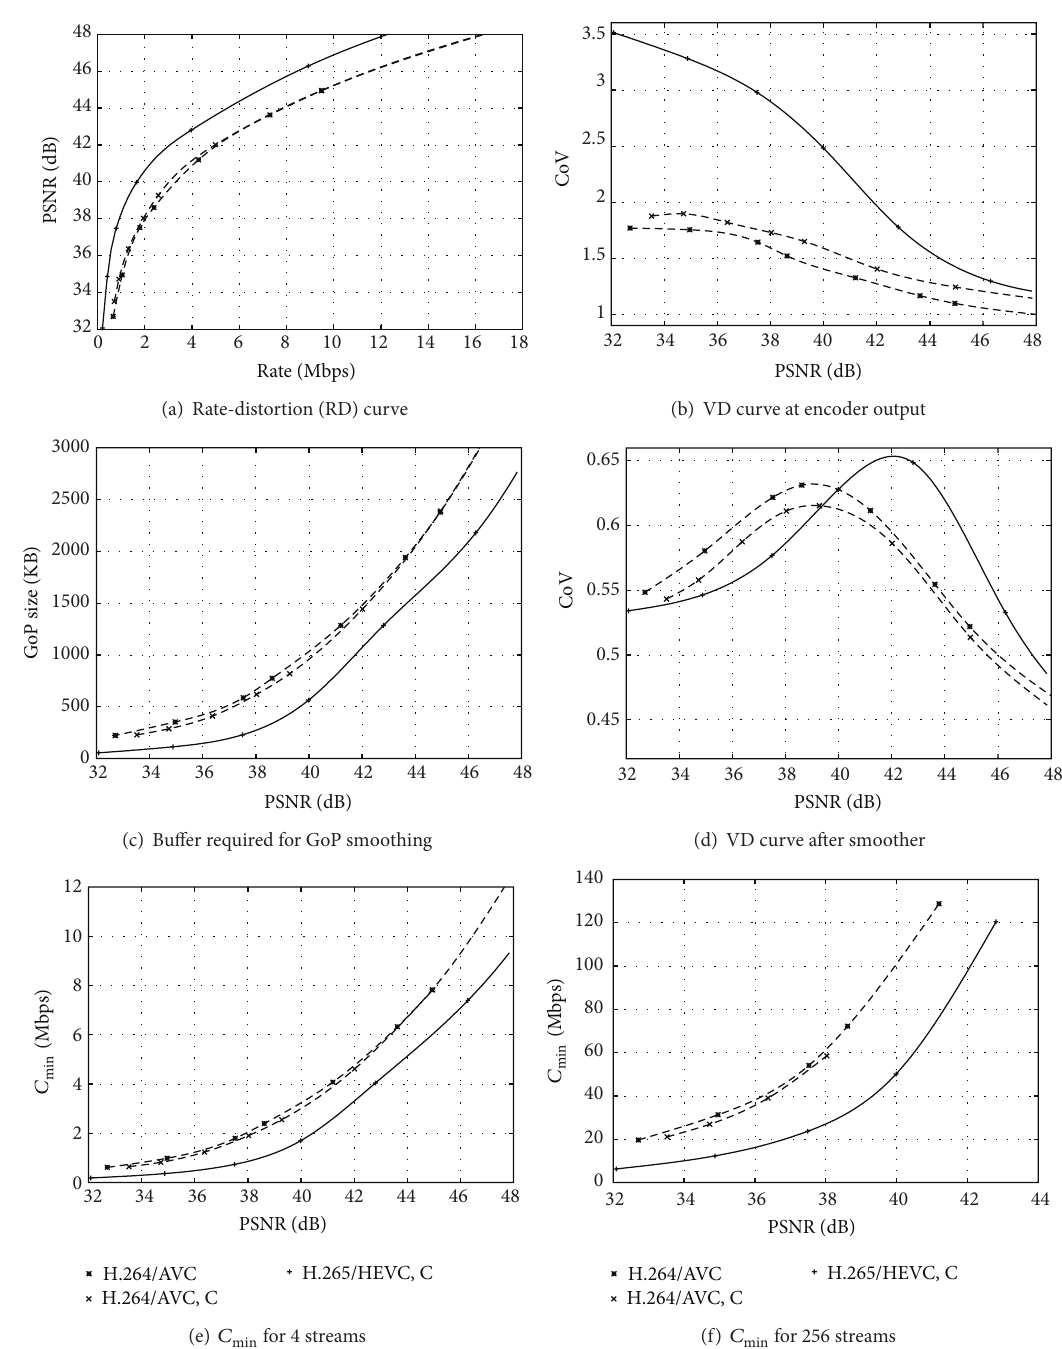
Figure 3: Traffic characteristics and link bandwidth requirements for H.264/AVC without and with cascading (C) quantization parameters (QPs) and H.265/HEVC with cascading QPs for Sony